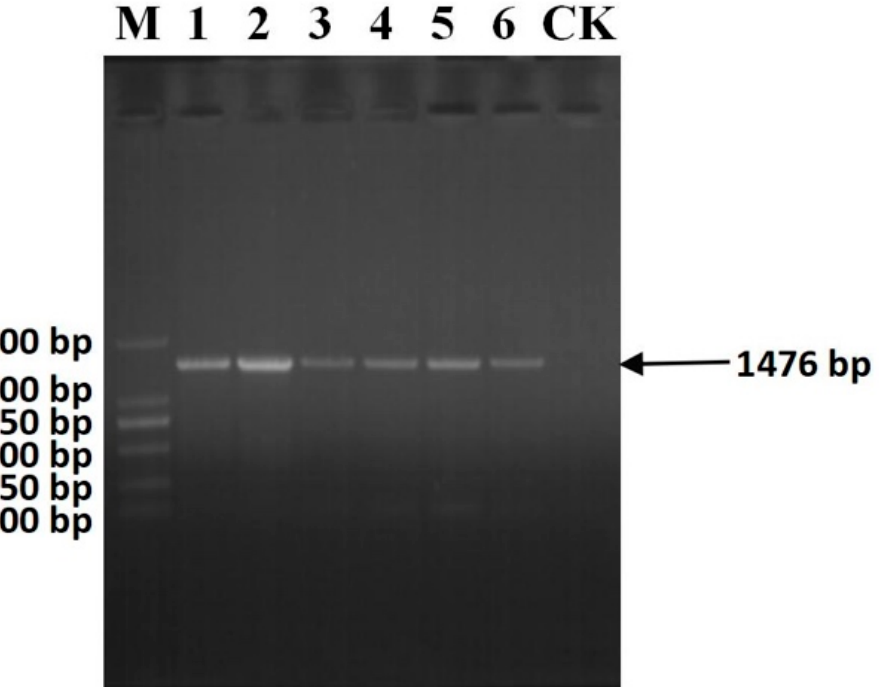
Figure 2. Identification of negative and positive seeds of transgenic maize plants with overexpression of AtAAP1 . Lane M represents the DL2000 DNA marker. Lanes 1–6 represent positive seeds of transgenic maize plants with the overexpression of AtAAP1 gene (1476 bp). CK represents the negative seed of transgenic maize plant (showing no presence of AtAAP1 ).